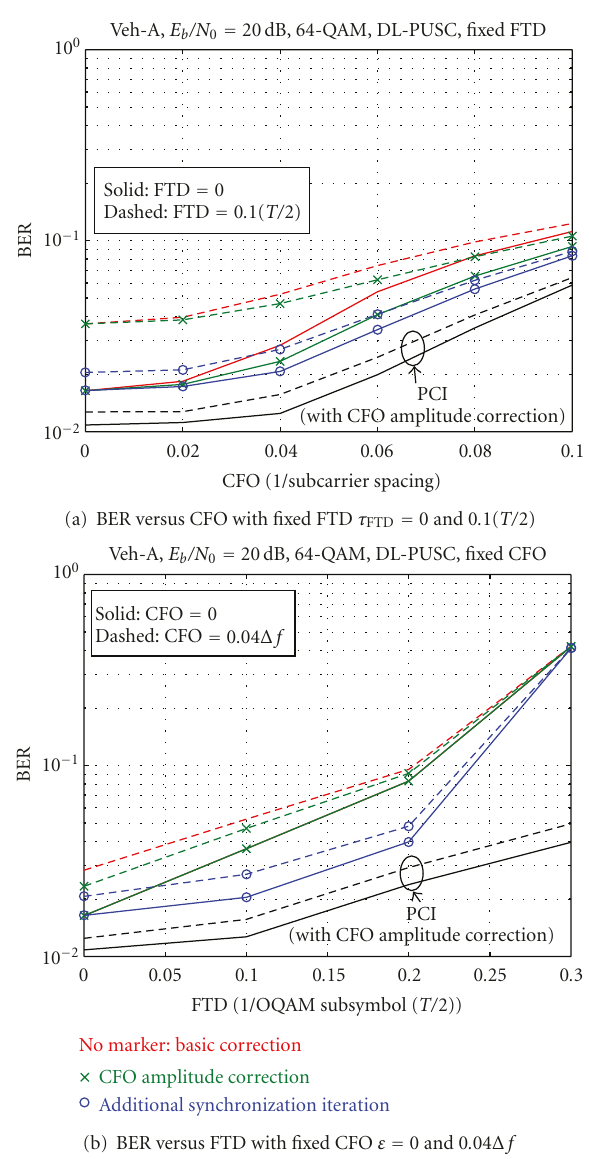
Figure 7: BER performance for di ff erent synchronization options and equalization of a DL-PUSC zone consisting of 4 MC symbols within Vehicular-A channel at E b /N 0 = 20dB, 64-QAM modula- tion.